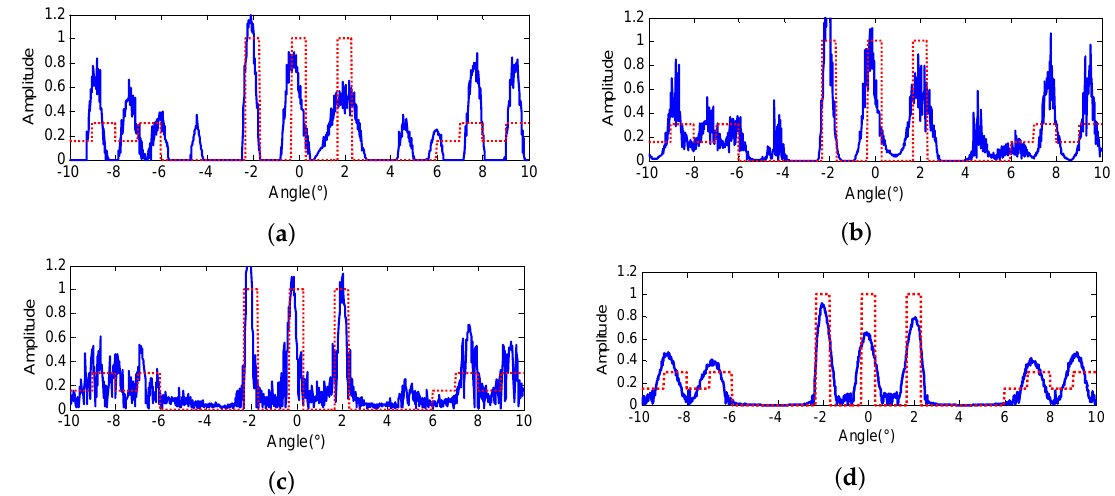
Figure 8. Super-resolution results of ( a ) Landweber ( b ) Richardson-Lucy (RL) ( c ) maximum a posterior (MAP) ( d ) proposed penalized maximum likelihood (PML), when the ISV equals 0.95 κ with SNR = 10 dB.